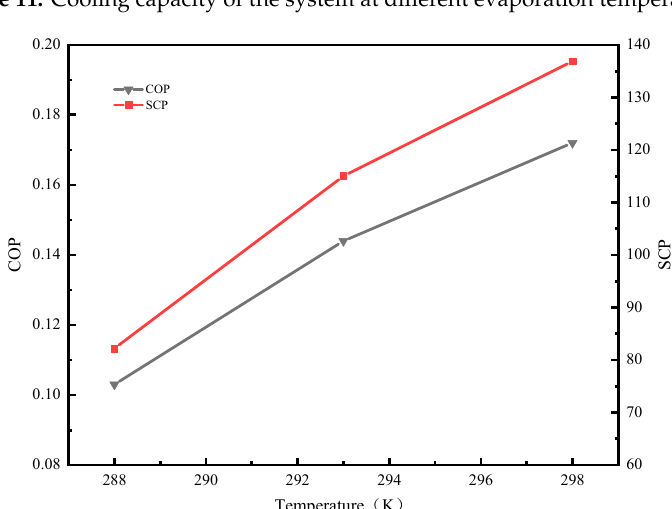
Figure 12. COP and adsorbent mass (SCP) of the system at different evaporation temperatures.